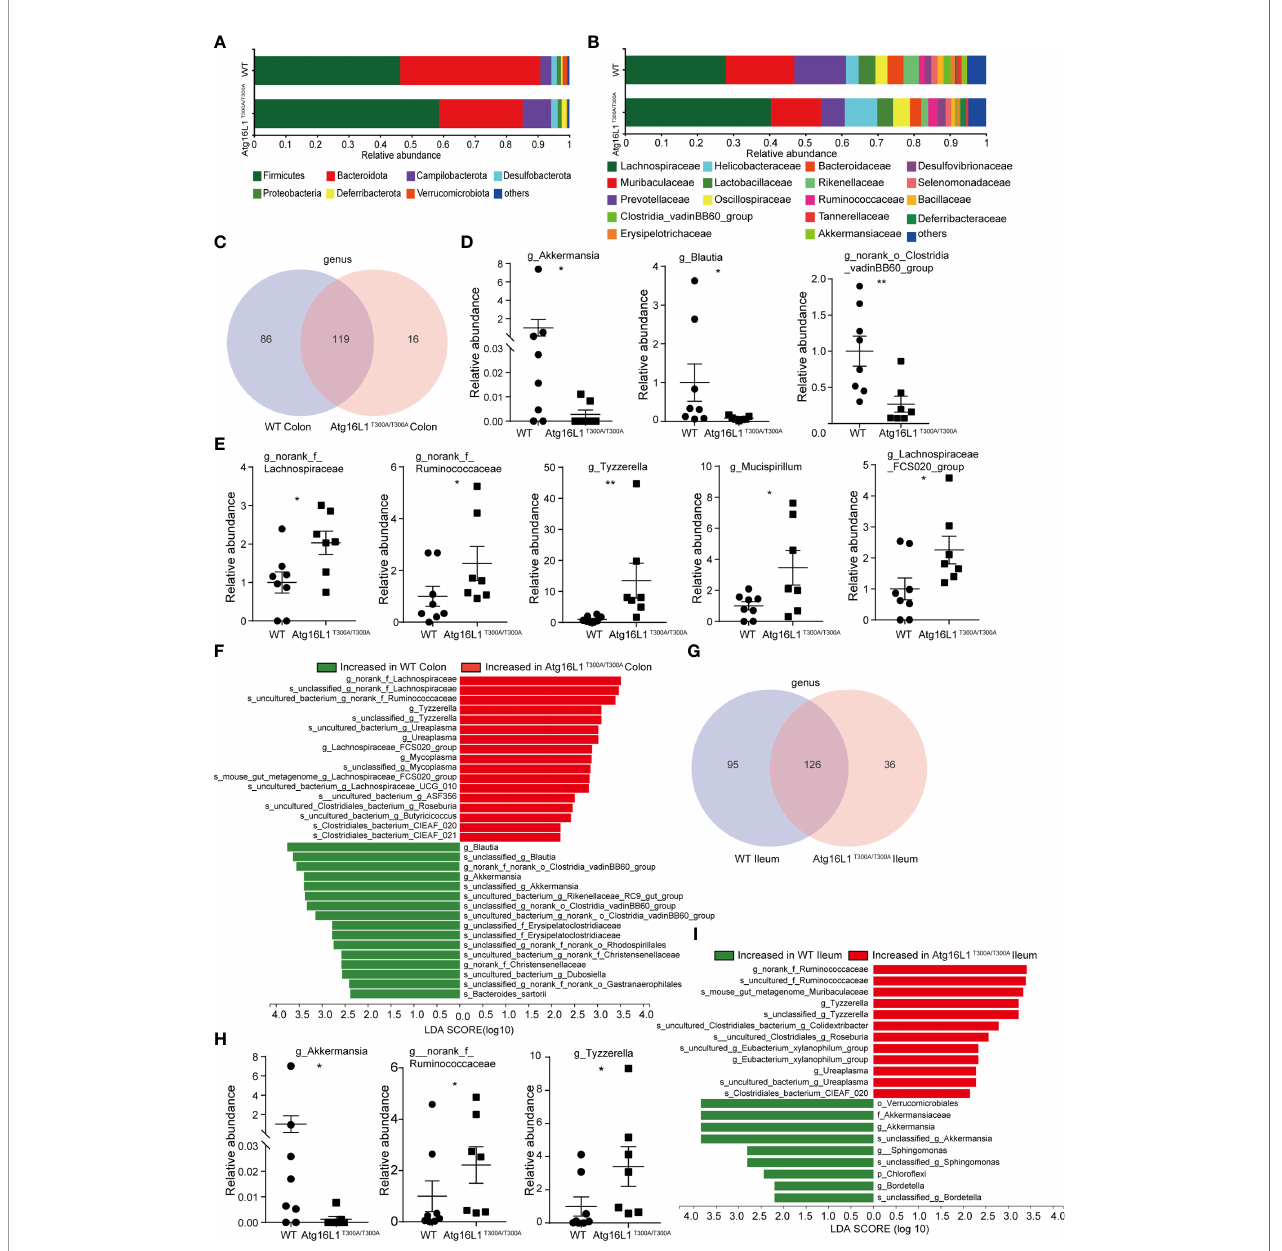
FIGURE 2 | Colonic and distal ileum mucosa microbial communities are altered in Atg16L1 T300A/T300A mice. WT and Atg16L1 T300A/T300A mice were cohoused in the SPF facility for 4 – 5 weeks after weaning at the third week of birth (WT mice n = 8 and Atg16L1 T300A/T300A mice n = 7). Mice sacri fi ced after being cohoused for 4 – 5 weeks and whole colon and distal ileum excised. DNA was extracted from the colonic mucosa lining, and 16S rRNA gene sequencing was performed to pro fi le bacterial taxa in each group. (A, B) The relative abundance of dominant bacteria at phyla- (A) and family- (B) level microbiota composition in colonic mucosa. Colored bars represent the relative abundance of particular taxa averaged in each group. (C) Venn diagram showing unique and shared genus among the WT and Atg16L1 T300A/T300A mouse colon mucosa. (D) Relative abundance of Akkermansia , Blautia , and norank_o_ Clostridia_vadinBB60 _group genus in WT and Atg16L1 T300A/T300A mouse colon mucosa scraping samples. Each dot represents an individual mouse sample. (E) Relative abundance of norank_f_ Lachnospiraceae , norank_f_ Ruminococcaceae , Tyzzerella , Mucispirillum , and Lachnospiraceae_FCS020 _group genus in WT and Atg16L1 T300A/T300A mouse colon mucosa scraping samples. Each dot represents an individual mouse sample. (F) Histogram of LDA value distribution identi fi ed by LEfSe analysis of colon mucosa scraping samples. (G) The common and speci fi c genus was shown by the Venn diagram between WT and Atg16L1 T300A/T300A mouse ileal mucosa. (H) Relative abundance of Akkermansia , norank_f_ Ruminococcaceae , and Tyzzerella genus in WT and Atg16L1 T300A/T300A mouse ileum mucosa scraping samples. Each dot represents an individual mouse sample. (I) Histogram of LDA value distribution identi fi ed by LEfSe analysis of ileum mucosa scraping samples. The relative bacterial abundance was calculated by normalizing each WT and T300A mouse bacterial abundance with the mean value of bacterial abundance of all WT mice. *p < 0.05, **p < 0.01 (non-parametric test followed by a Mann – Whitney